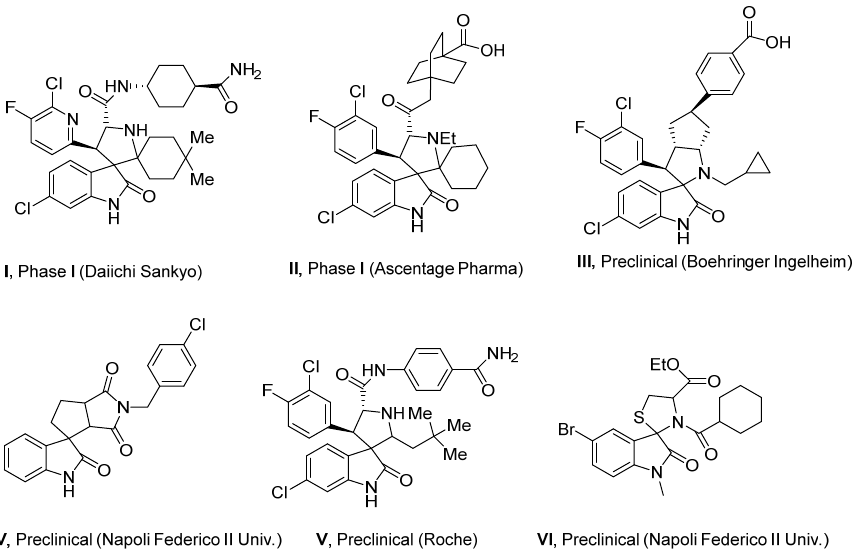
Figure 3. Examples of small-molecule MDM2 inhibitors with spiro-oxindole fragments in the molecules [40 − 44].